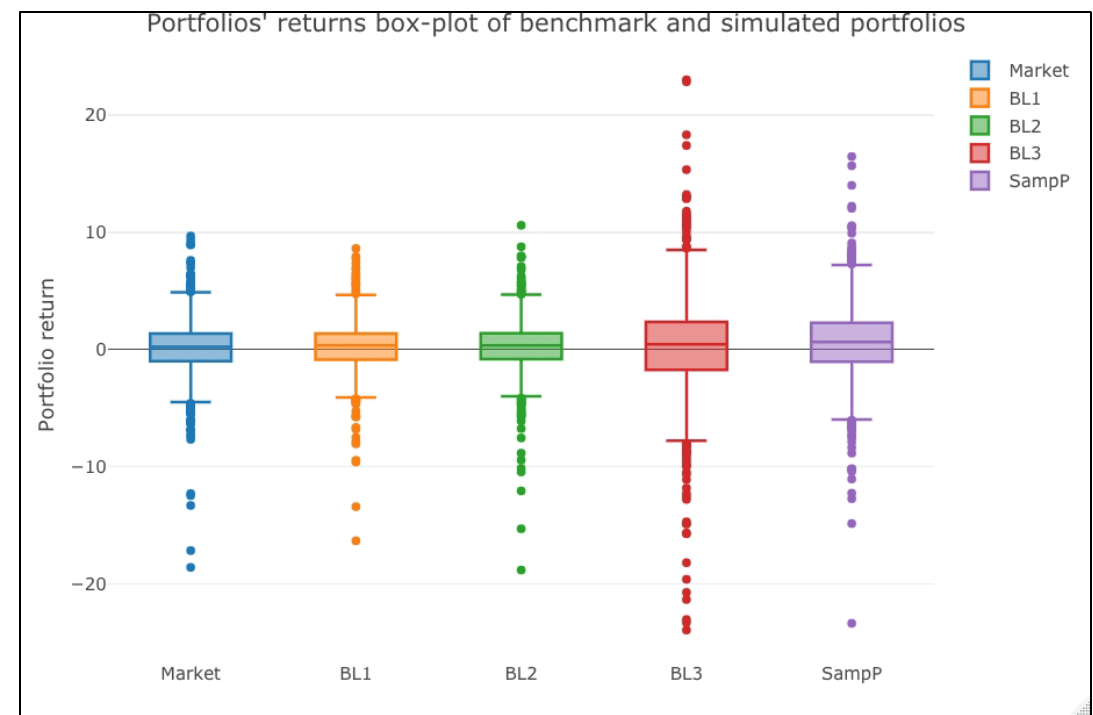
Figure 3. Simulated portfolios’ returns boxplots.